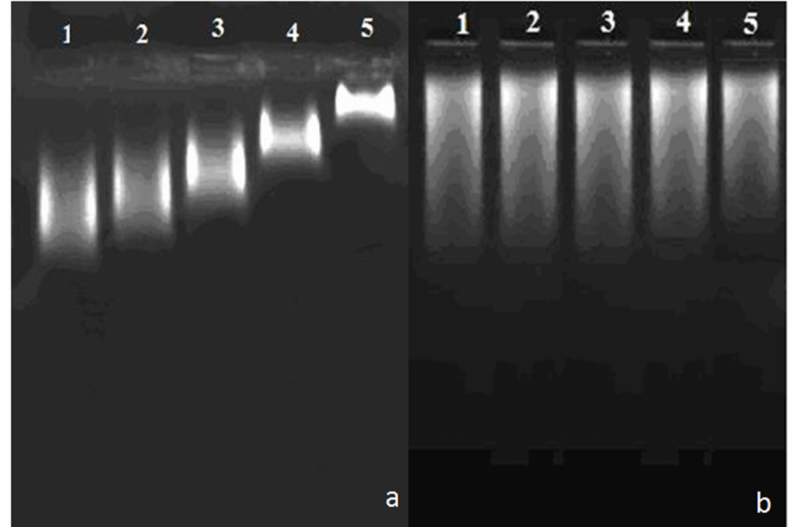
Figure 5. Band shift assay of IgG from bladder cancer patients (smoker group) using ( a ) modified human DNA and ( b ) native human DNA. Electrophoresis was carried out on 0.8% agarose gel for 2 h at 30